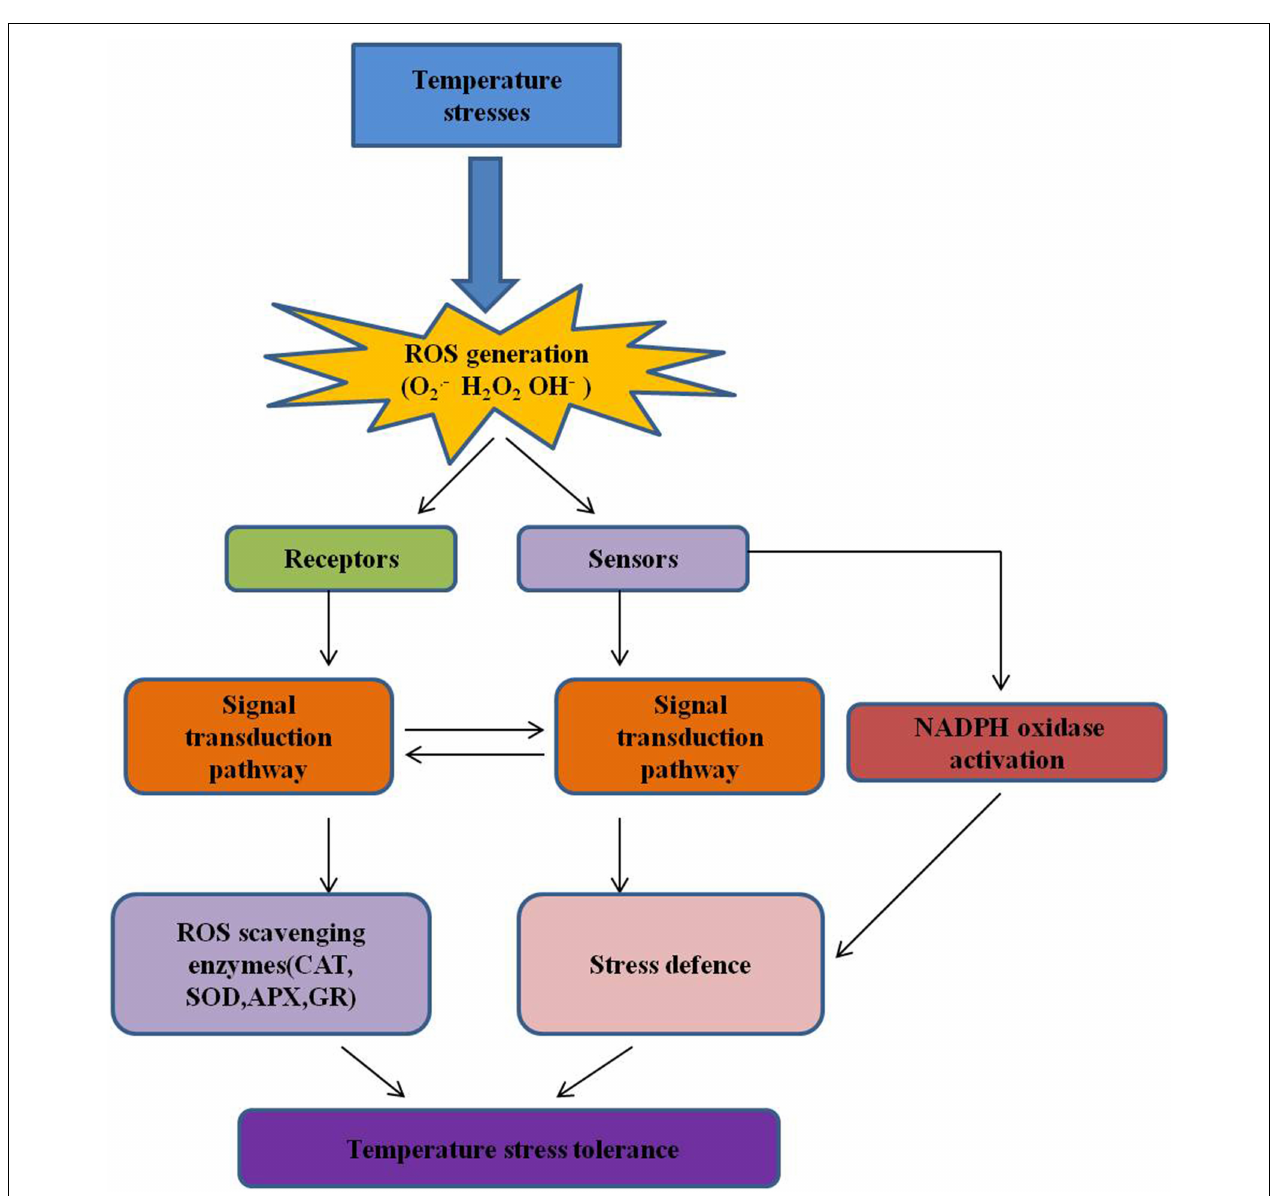
FIGURE 5 | ROS and redox homeostasis in temperature stress. ROS production in plant cells is a consequence of various stimuli due to abiotic stress, and modulation by antioxidants, as well as cell metabolism (Suzuki and Mittler, 2006). During stress, ROS overproduction can pose a threat to plant cells, and many stress conditions can enhance the expression of ROS-scavenging enzymes (De Gara et al., 2010). ROS are actively produced by cells (e.g., by NADPH oxidase in membranes) in